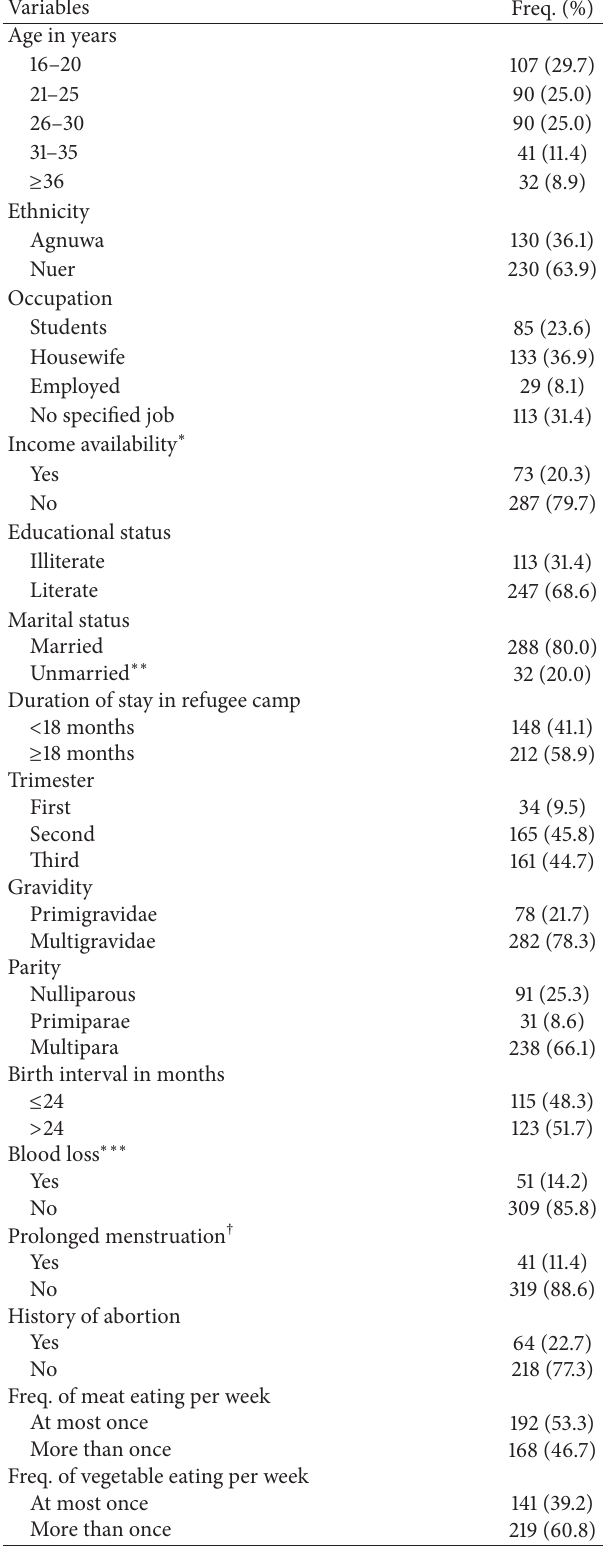
Table 1: Sociodemographic, obstetric, nutrition, and clinical char- acteristics of refugee pregnant women attending ANC clinic at PugnidoARRAHealthCenter,Gambela,westernEthiopia,April15– June